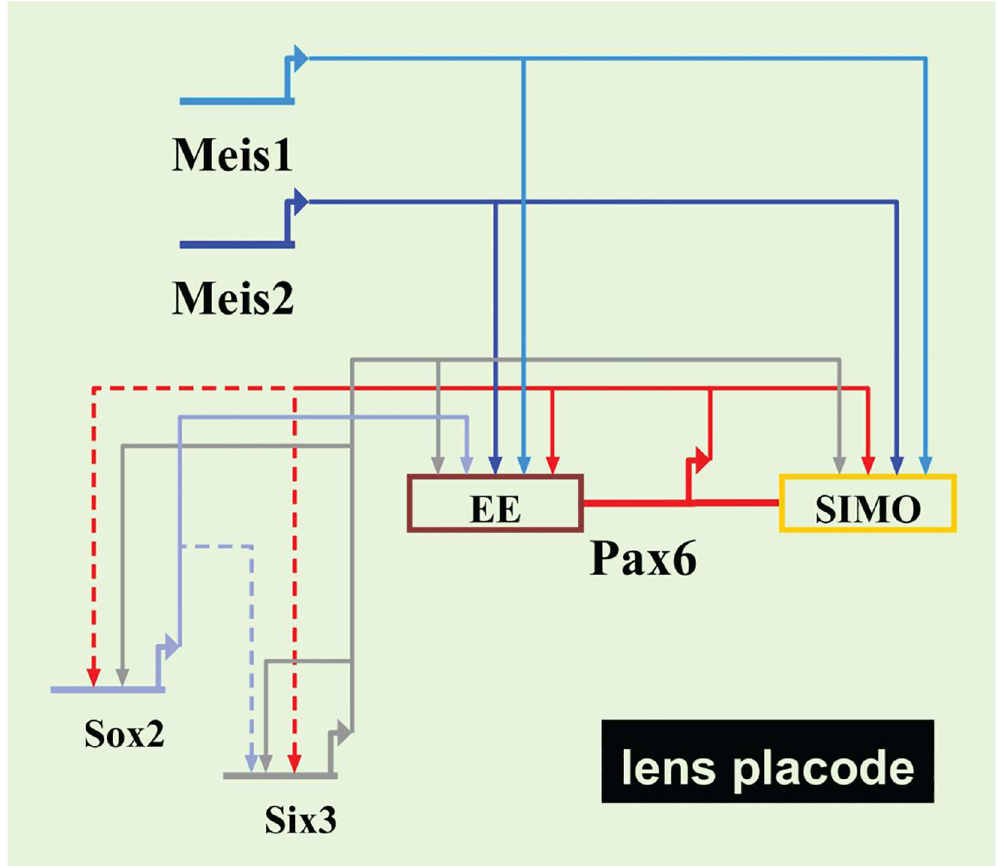
Fig 7. Current model of transcriptional regulatory network operating during mammalian lens induction. Direct interactionsare indicatedwith solid lines, whereasdashed lines show possibledirect interactions inferred from gain- and loss-of-function